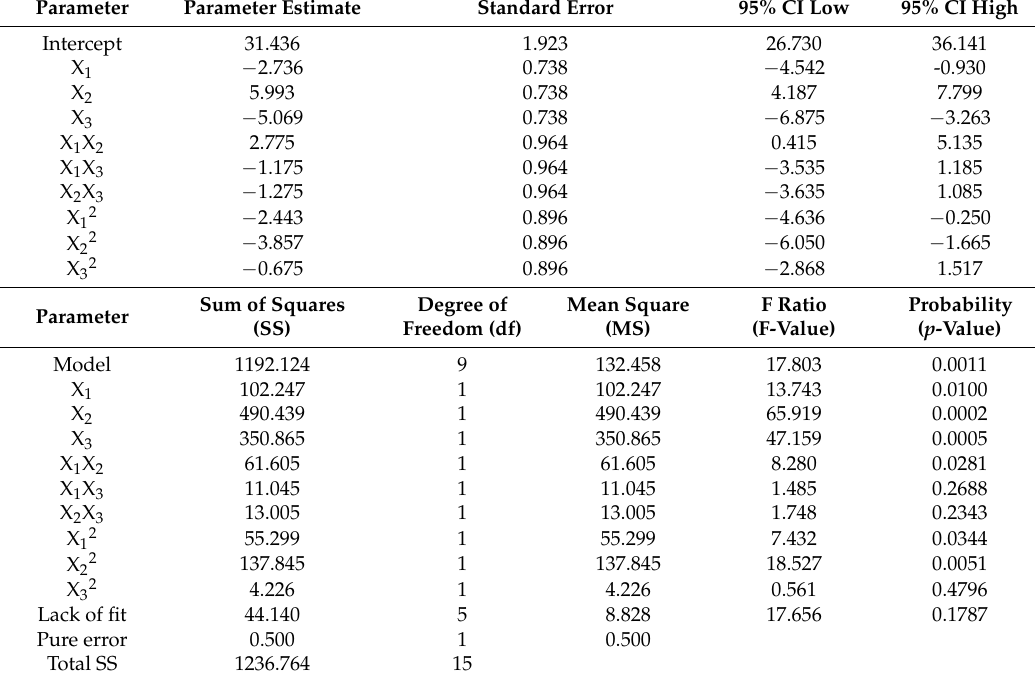
Table 8. Results of the regression model and ANOVA for